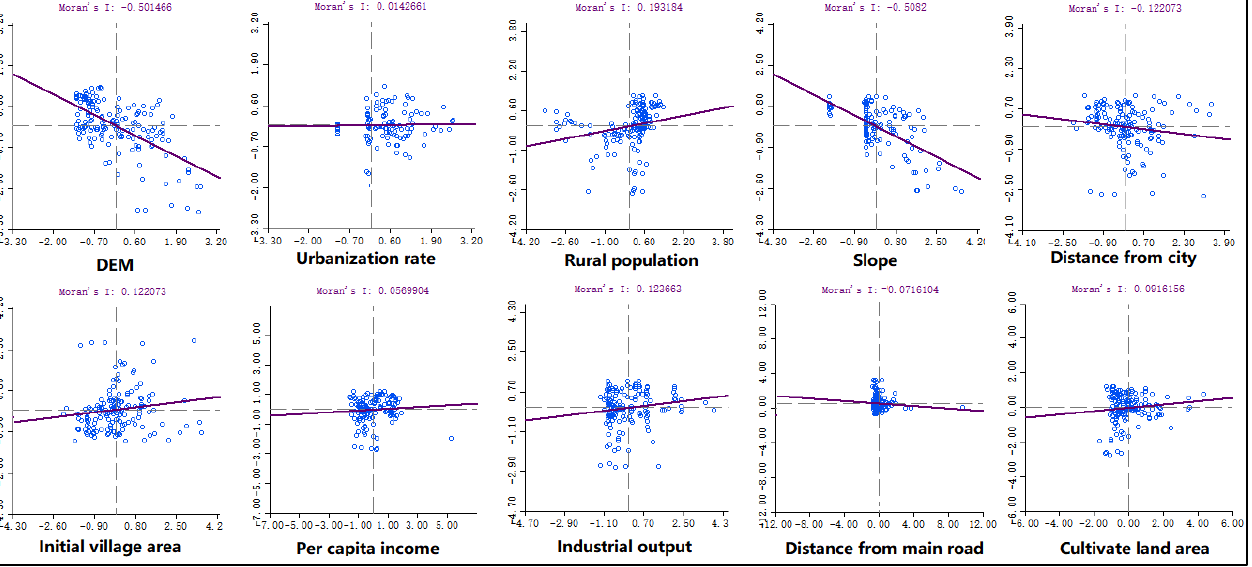
Figure 13. Bivariate spatial autocorrelation Moran index values.